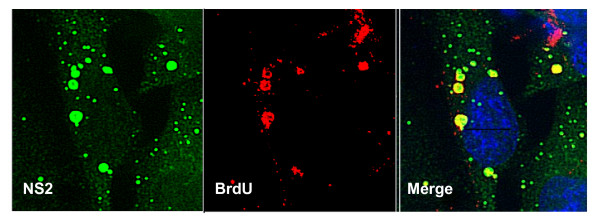
Intracellular sites of RNA synthesis in BTV infected cells. Co-localization of NS2 (green) and BrUTP labeled RNA (red) in BSR cells infected with BTV-10 (MOI of 1) 17 h p.i. The cells were treated with actinomycin D prior to immunostaining.